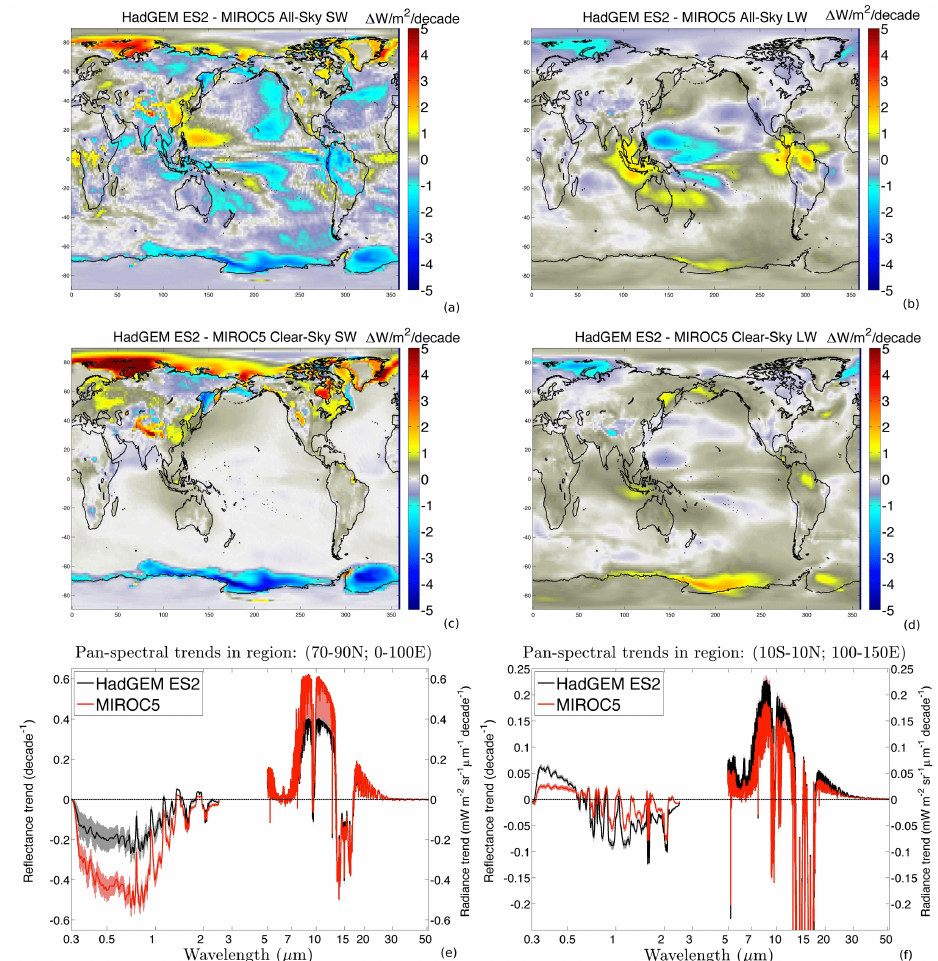
Figure 4. (a) Difference in all-sky shortwave TOA flux trends between HadGEM2-ES and MIROC5 running the RCP8.5 scenario over the period 2005–2035. (b) Same as (a) but for long-wave TOA flux trends. (c) Same as (a) but for clear-sky shortwave TOA flux trends. (d) Same as (a) but for clear-sky long-wave TOA flux trends. (e) Pan-spectral all-sky trends shortwave reflectance and long-wave radiance for the MIROC5 and HadGEM2-ES models derived for the Arctic (70–90 ◦ N, 0–100 ◦ E) and (f) for the tropical western Pacific (10 ◦ S–10 ◦ N, 100-150 ◦